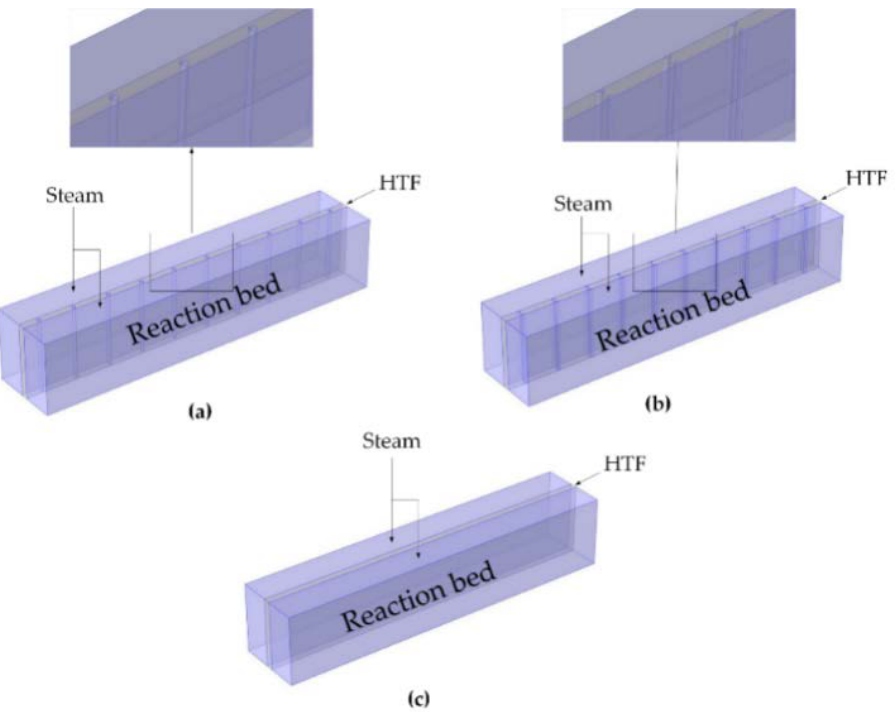
Figure 2. One research unit of the reactor. ( a ) Plate pin fin heat sinks (PPFHS). ( b ) Half-plate pin fin heat sinks (HPPFHS). ( c ) Plate fin heat sinks (PFHS).